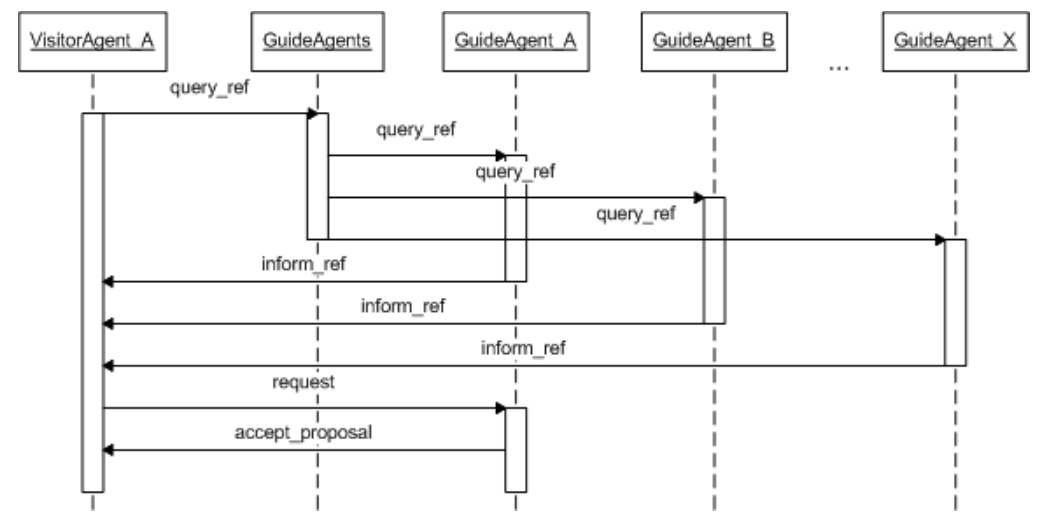
Figure 14. UML sequence diagram of the negotiation process between a VisitorAgent and a the group of GuideAgents